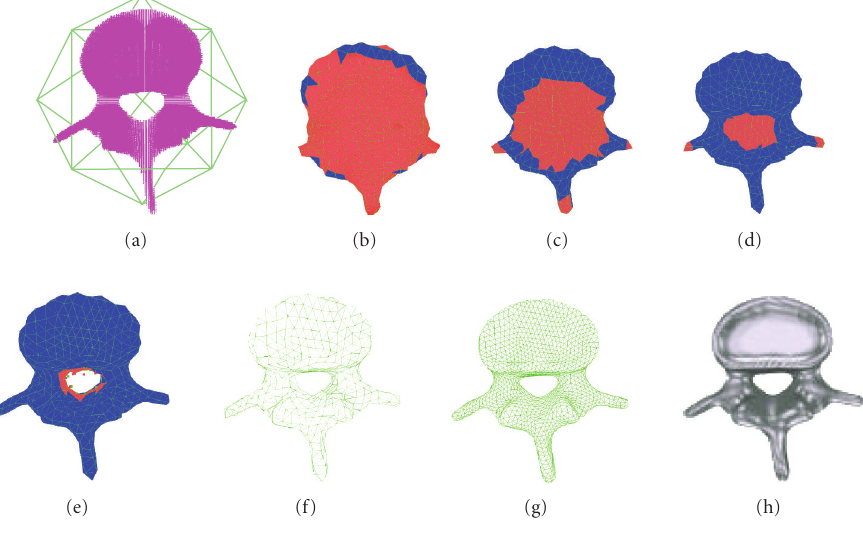
Figure 4: Segmentation of a CT volumetric dataset of a human vertebra.